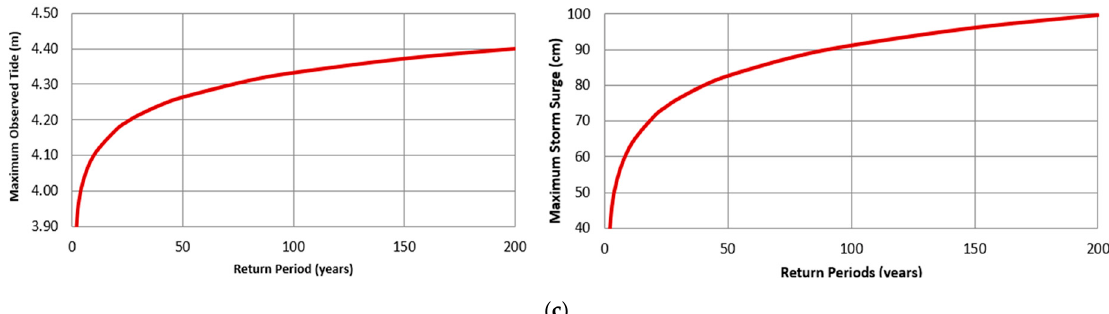
Figure 3. Return period curves for the maximum observed tide (left), relative to the TG chart datum, and the maximum storm surge (right) for: ( a ) the Viana do Castelo TG (1978–2008 data series); ( b ) the Cascais TG (1959–2018 data series); ( c ) the Lagos TG (1986–2018 data series). Table 1. Maximum tide height, relative to the respective TG chart datum, and storm surge (SS) for the 50-, 100-, and 200-year return periods, for the previous three